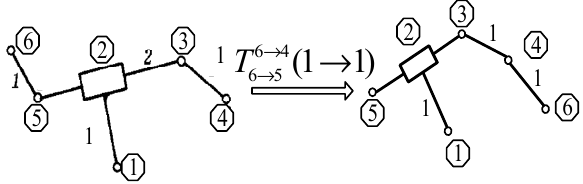
Figure 2. Inversion operation.